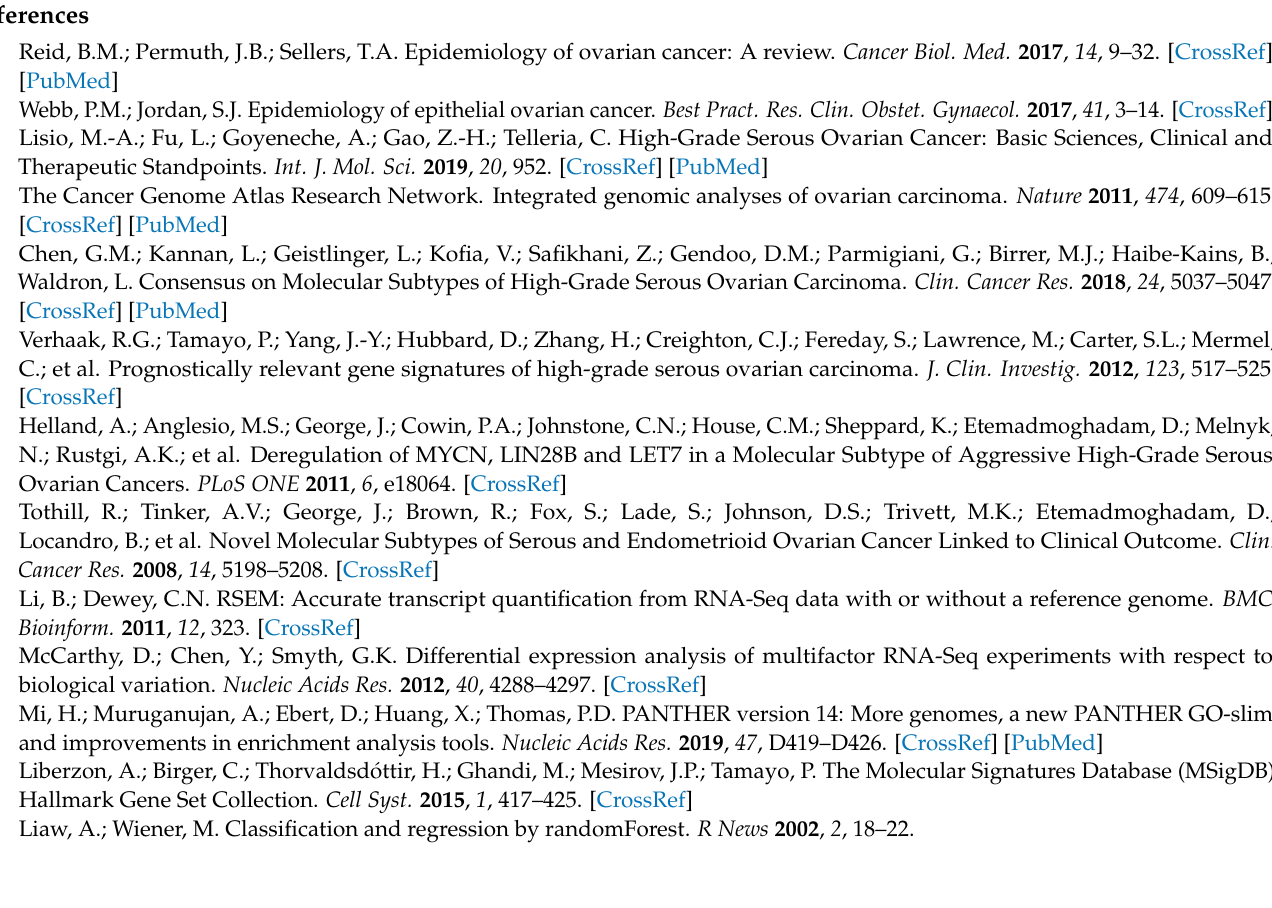
according to RPL23 mRNA expression levels, Table S1: Relationship between clinical stage and response to conventional chemotherapy, Table S2: Differentially expressed 550 genes identified in the comparison of early vs. advanced stages, Table S3: Differentially expressed 100 genes identified in the comparison of response groups of platinum therapy among 43 patients with advanced HGSC, Table S4: Twenty-eight genes associated with prognosis of